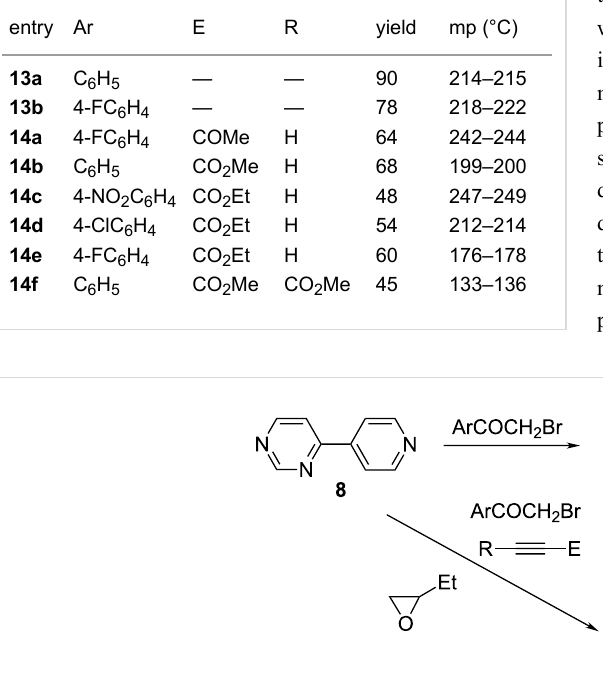
Table 2: The bromide salts 13 and the new 6-pyrimidinylindolizines 14